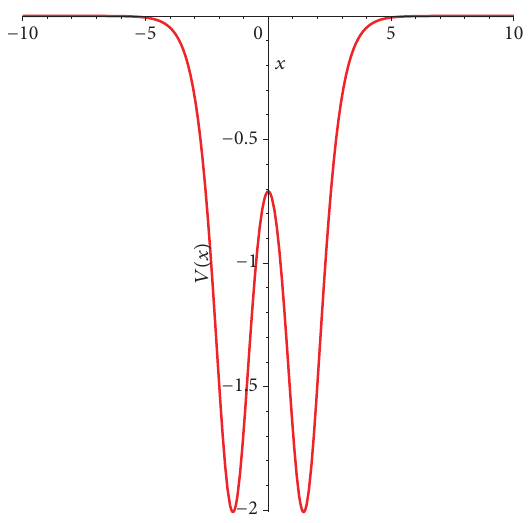
Figure 2: Plot of the QES DWP as a function of 𝑥 for V 1 = 0.09 , V = −9 , and V = 10 2 3